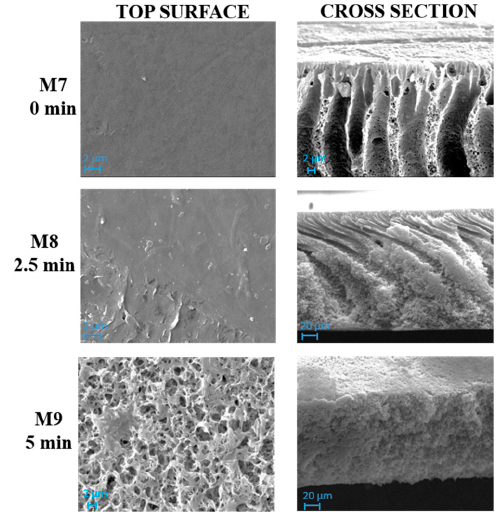
Figure 5. SEM images of M7, M8 and M9 membranes prepared with PVDF, PVP, PEG, GO and TEP and exposed to humidity for 0, 2.5 and 5 min, respectively. Magnification: top surface 10,000×, cross section 1000×.